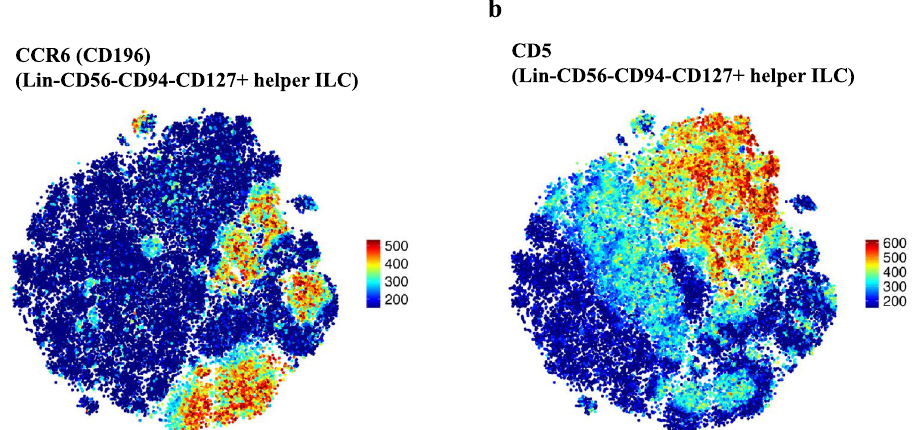
Figure 4. FIt-SNE depicts CCR6 (CD196) and CD5 expression on helper ILC. Expression levels of ( a ) CCR6 (CD196) and ( b ) CD5 among Lin−CD56−CD94−CD127+ helper ILC on Fast interpolation-based t-stochastic neighbor embedding (Fit-SNE) plots. A subsample of up to 70,000 cells from all study participants (non-MS controls, MS patients from all timepoints and batch controls) were included for the generation of FIt-SNE plots.